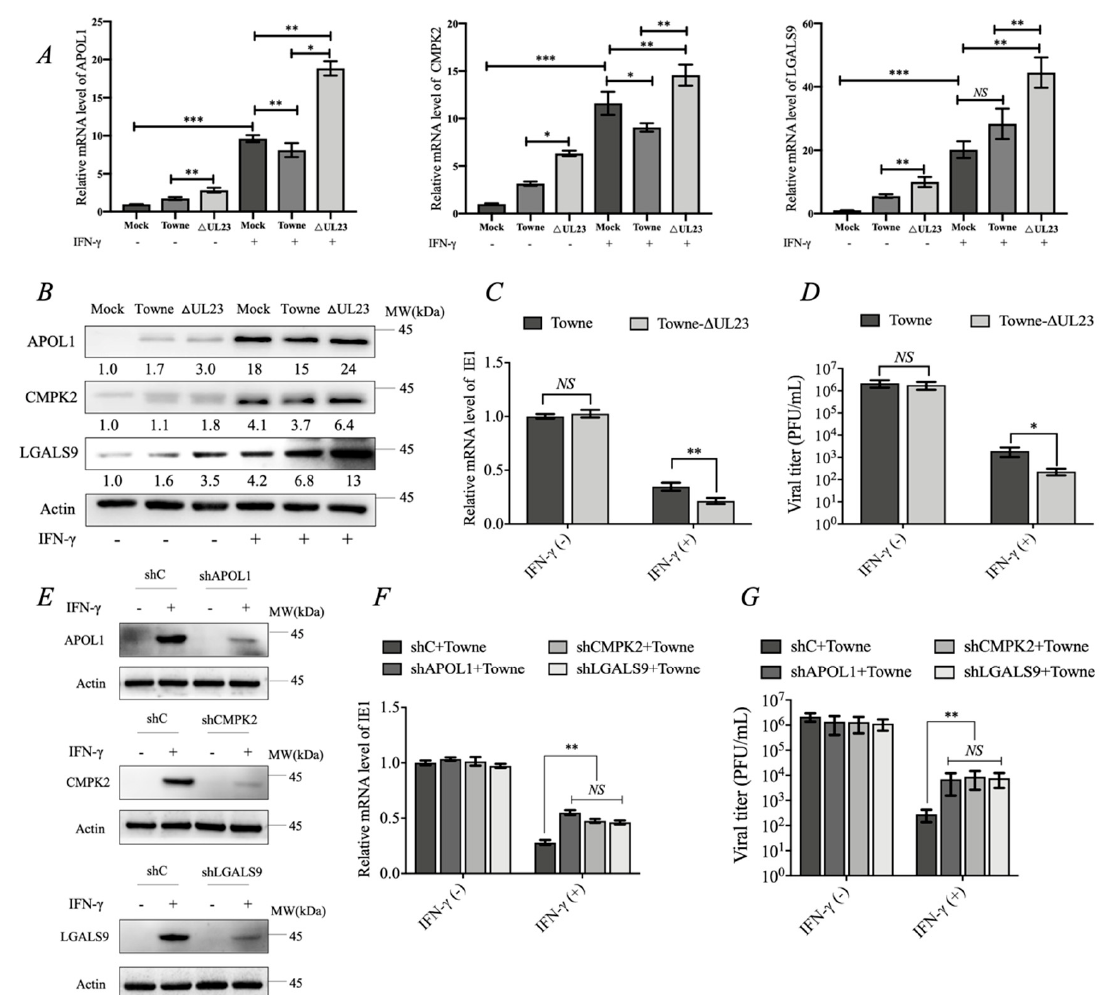
Figure 4. UL23 resisted the antiviral effect of IFN- γ by downregulating the expression of APOL1, CMPK2, and LGALS9. ( A , B ) The effect of HCMV UL23 on the gene expression of APOL1, CMPK2, and LGALS9 with or without IFN- γ (1000 U/mL) stimulation during the HCMV infection (before HCMV infection, HFF cells were pretreated with IFN- γ for 12 h). Total RNAs were prepared at 24 h, the level of genes was measured by RT-qPCR, and total cell lysates were prepared and analyzed by immunoblotting. ( C ) HFF cells were infected with HCMV-Towne or HCMV-Towne- ∆ UL23 at an MOI of 1 and treated with or without 1000 U/mL IFN- γ for 24 h (before HCMV infection, HFF cells were pretreated with IFN- γ for 12 h). Total RNAs were prepared at 24 h, and the level of IE1 transcripts was measured by RT-qPCR. ( D ) Cell culture supernatants from cells infected with HCMV-Towne or HCMV-Towne- ∆ UL23 at an MOI of 1 were analyzed 7 days post-infection for progeny virus titers using infectious center assays in HFF cells. ( E ) HFF cells were stably transduced to the target gene with lentiviruses containing non-target control shRNA (NT) or shRNAs (APOL1, CMPK2, and LGALS9). ( F ) Control and stable knockdown HFF cells (APOL1, CMPK2, and LGALS9) were infected with HCMV-Towne at an MOI of 1 and treated with or without 1000 U/mL IFN- γ for 24 h (before HCMV infection, HFF cells were pretreated with IFN- γ for 12 h). Total RNAs were prepared at 24 h, and the level of IE1 transcripts was measured by RT-qPCR. ( G ) Cell culture supernatants from cells infected with HCMV-Towne at an MOI of 1 were analyzed 7 days post-infection for progeny virus titers using infectious center assays in HFF cells. Data are shown as mean ± SD. * p < 0.05, ** p < 0.01, *** p < 0.005, NS denotes not significant ( p > 0.05). Data are representative of three independent experiments with similar